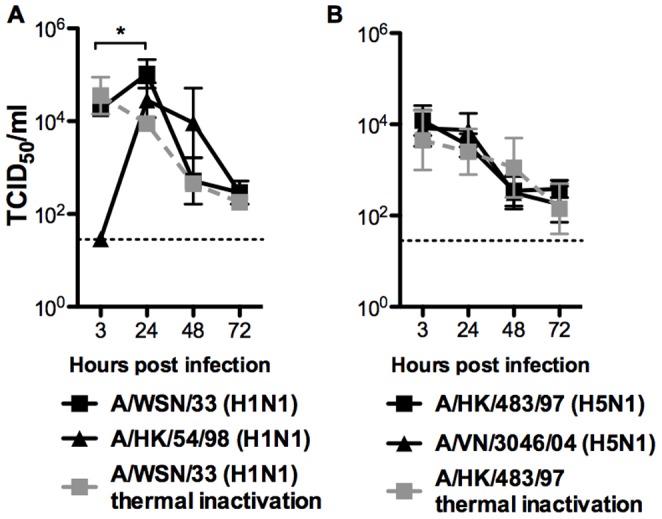
Virus titer detected in the supernatant of influenza A virus infected mouse bone marrow derived macrophages.Virus titer of various (A) influenza H1N1, and (B) H5N1 influenza viruses was determined at 3, 24, 48 and 72 h post-influenza virus infection of mouse bone marrow derived macrophages. Means and standard error of triplicate assays were shown. Dotted line represents the lowest detection limit of the TCID50 assay. The thermal inactivation (serial dilution of influenza virus was incubated in the cell-free culture medium alone at the corresponding time points) curves (dotted line) of influenza H1N1 and H5N1 viruses at 37°C were determined from culture wells without macrophages.